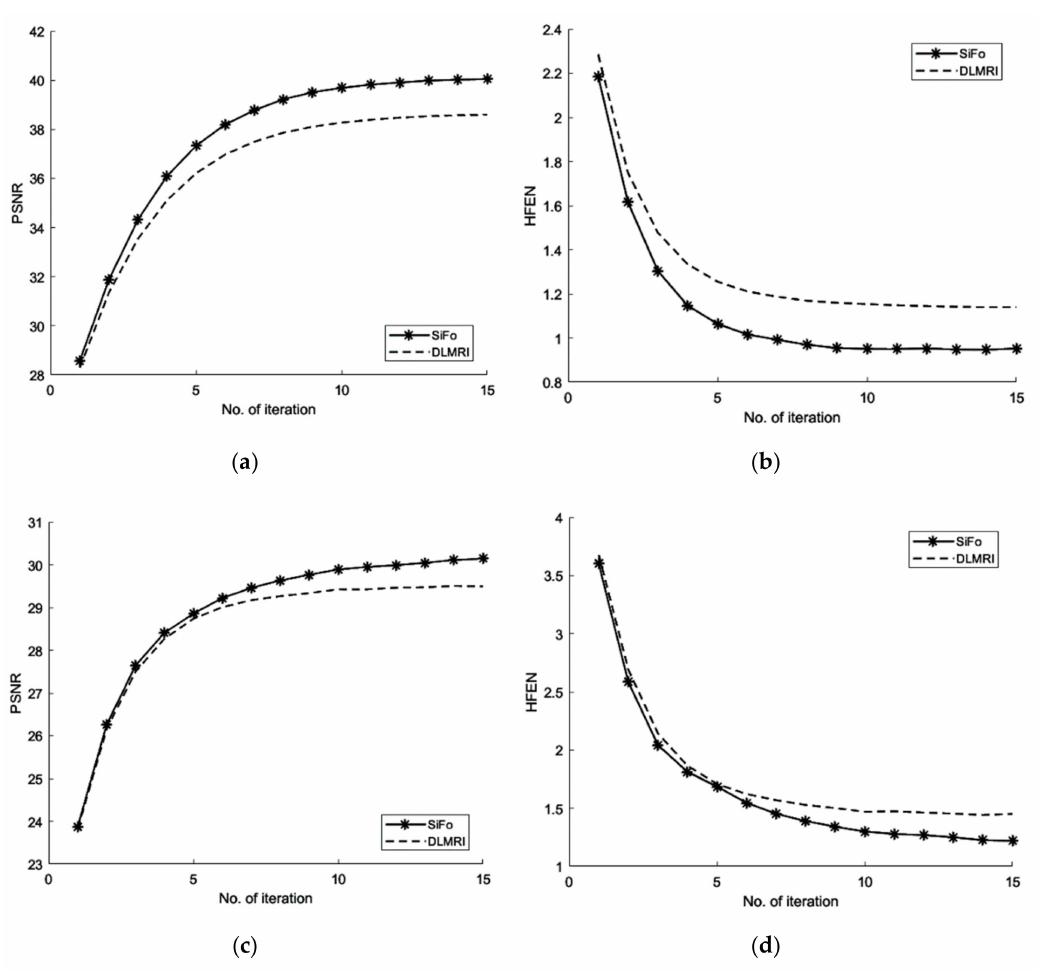
Figure 3. Algorithms performance for a noisy case. ( a ) PSNR vs. iterations with comparison to DLMRI for brain image; ( b ) HFEN vs iterations with comparison to DLMRI for a brain image; ( c ) PSNR vs. iterations with comparison to DLMRI for a phantom image; ( d ) HFEN vs iterations with comparison to DLMRI for a phantom